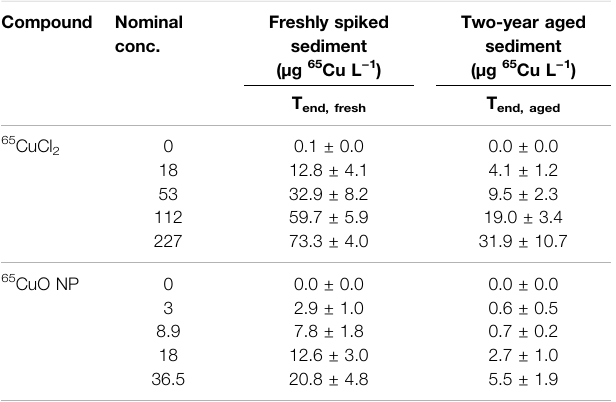
TABLE 2 | Water 65 Cu concentrations from experiments with freshly spiked sediment and sediment aged for 2 years. Compound Nominal conc.